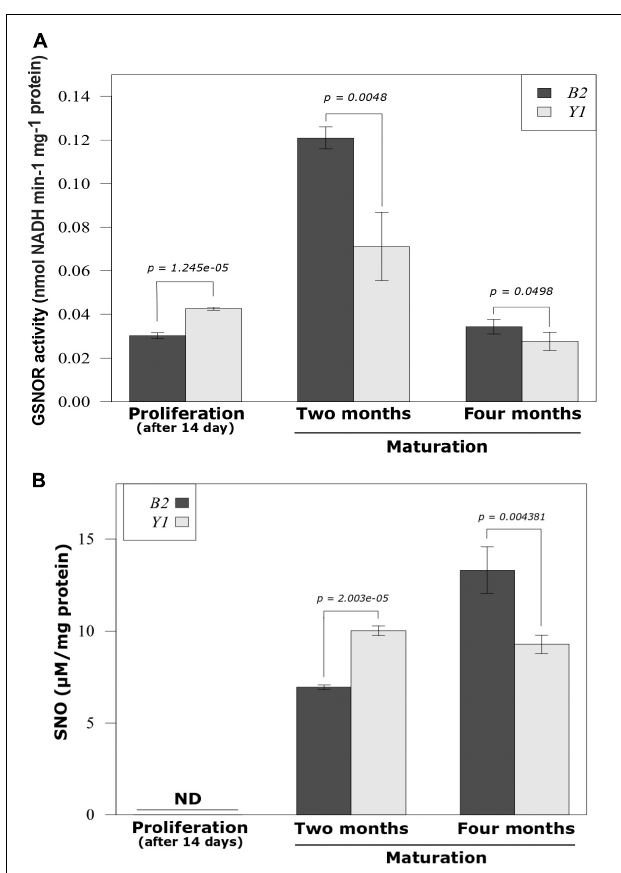
FIGURE 2 | GSNOR activity and endogenous S-nitrosothiol (SNO) level during the proliferation of proembryogenic masses and development of somatic embryos in Brazilian pine. (A) S-nitrosoglutathione reductase (GSNOR) activity. (B) Endogenous -SNO level. The bars represent the mean and lines indicate the standard error of the mean. Three biological replicates were used for determination of endogenous -SNO levels and four biological replicates were tested for GSNOR activity. Student’s t -test was used to determine significant differences in the mean values between pairwise comparisons. B2, cell line blocked to somatic embryo formation; Y1, cell line responsive to somatic embryo formation.